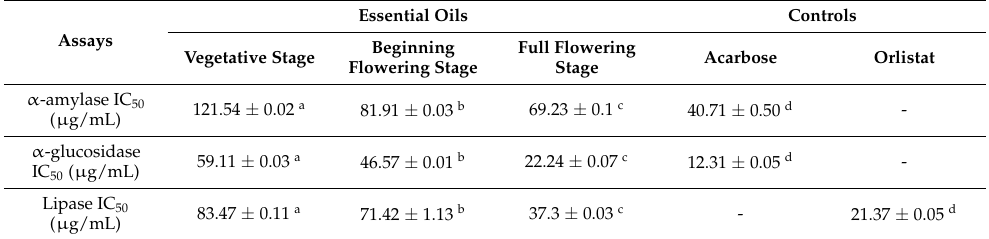
Table 4. The antidiabetic activity of SOEO (IC 50 in µ g/mL) at three developmental stages. The results are presented as means ± SD (standard deviations) for triplicate assays.